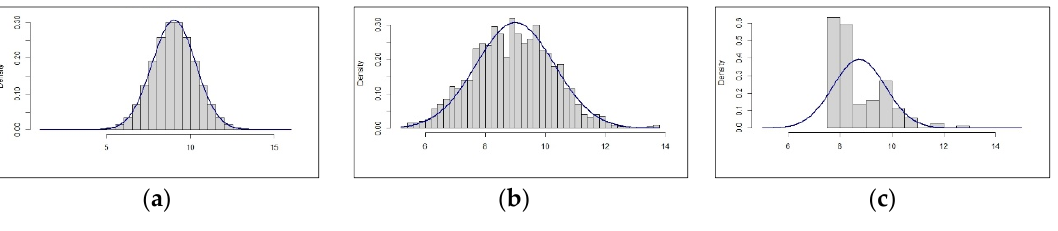
Figure 3. Types of data distributions ( a ) perfect; ( b ) good form; ( c ) ugly.